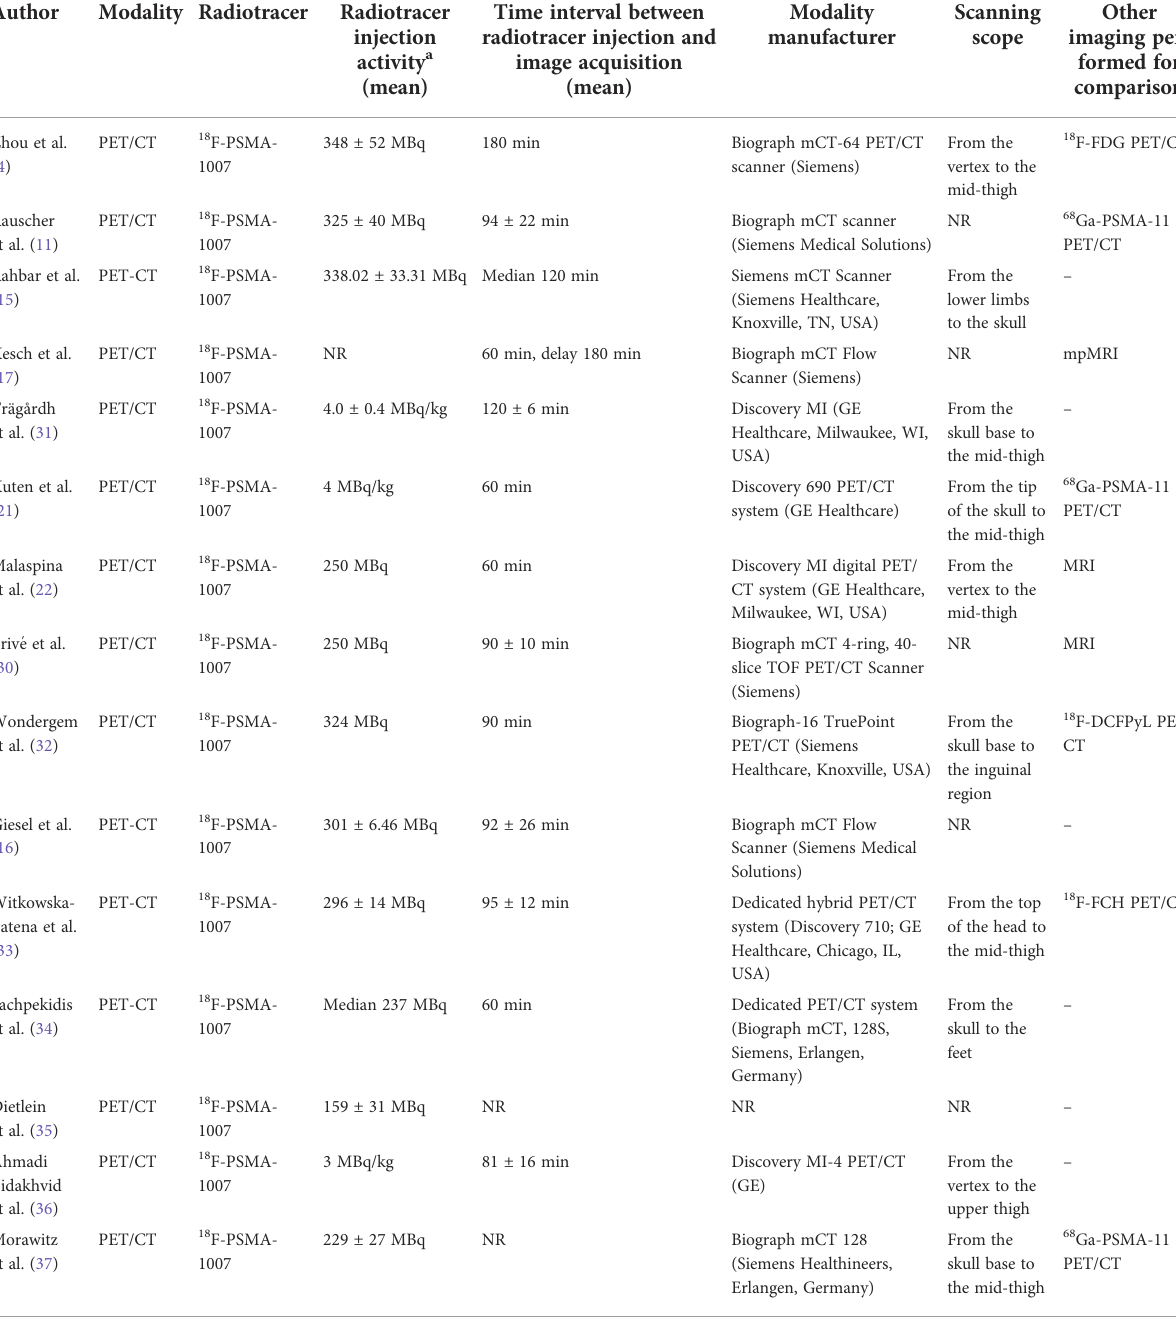
TABLE 2 Technical aspects of 18 F-PSMA-1007 in the included